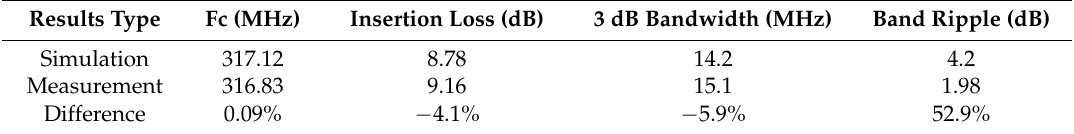
Table 1. Results analysis between the simulation and